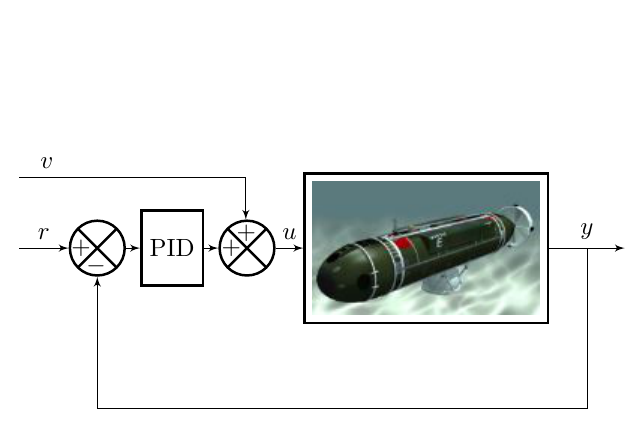
Figure 2: Example 4.1. The figure shows the closed loop system where the process is a nonlinear deep submergence rescue vehicle. Output,